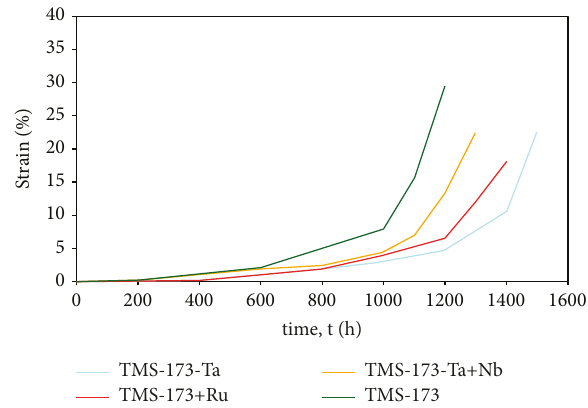
Figure 4: Variation in creep life with respect to strain % at 900 ° C temperature and 392MPa stress